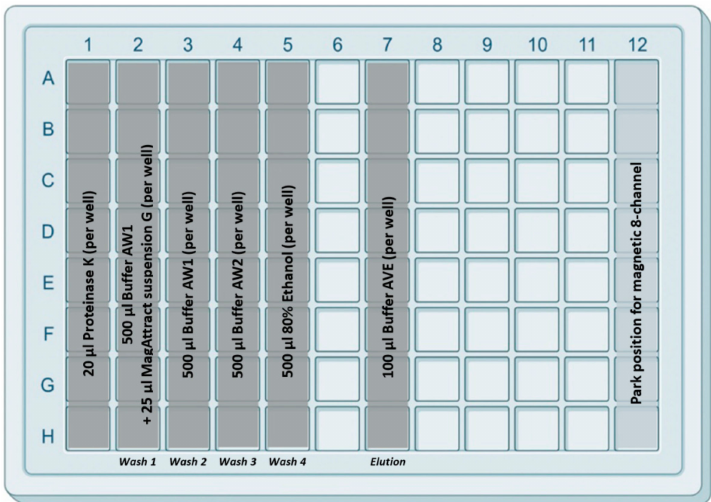
Figure 2. Design of the 96-deep well plate with the prefilled reagents. In the first column, 20 µ L proteinase K solution was added, and the second column was filled with 25 µ L of magnetic beads (Mag-Attract Suspension G) per well. Washing buffers AW1, AW2 and 80% Ethanol were filled in columns 2 to 5 (500 µ L/well) as illustrated. Finally, in column 7, 100 µ L/well of elution buffer AVE was added. Columns 6 and 8–12 remained empty. (The figure was created with a 96-well square well plate template from BioRender.com with